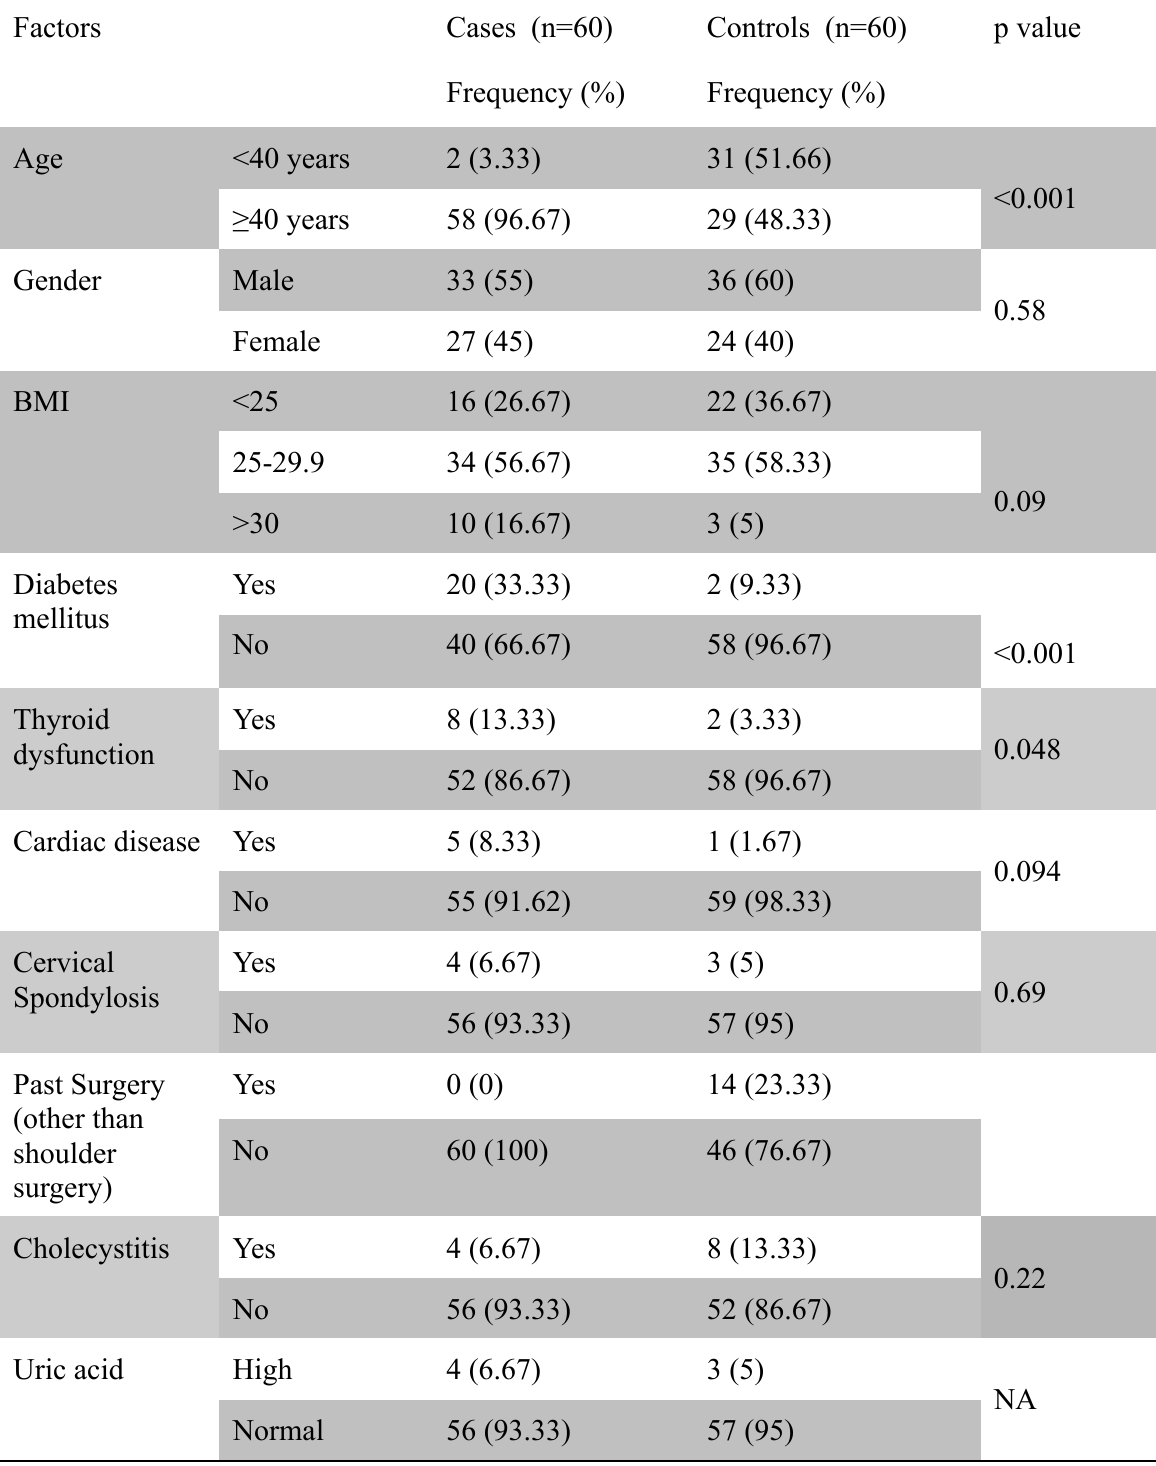
Table 1: Distribution of selected demographic variables and risk factors in frozen shoulder cases and